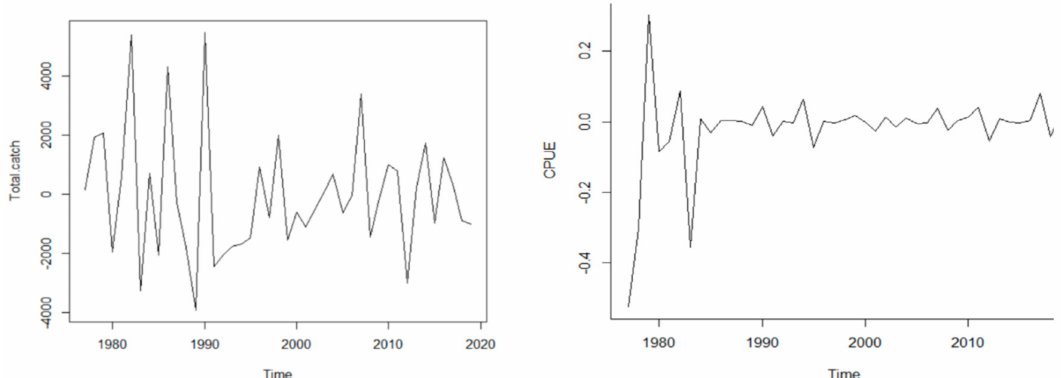
Figure 4. First order